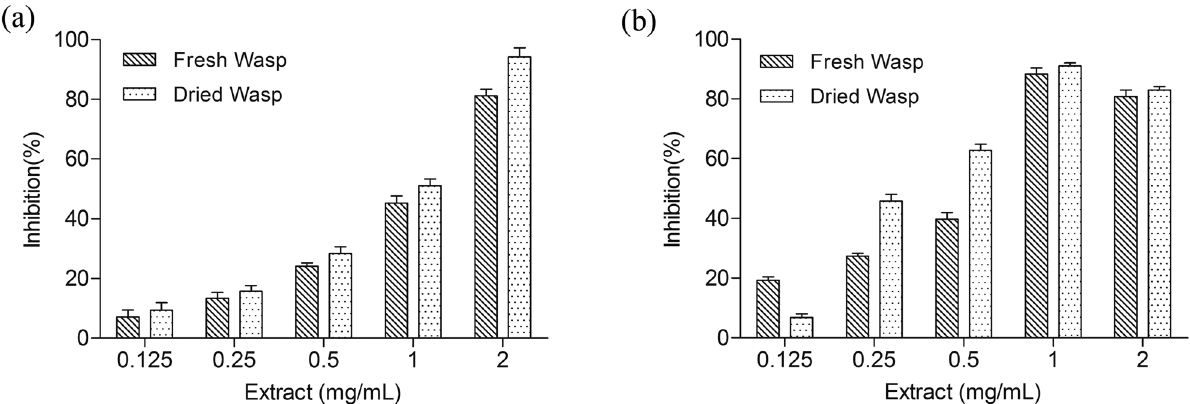
Figure 1: The e ff ects of V. auraria extract for the inhibition of the ABTS ( a ) and DPPH ( b ) .